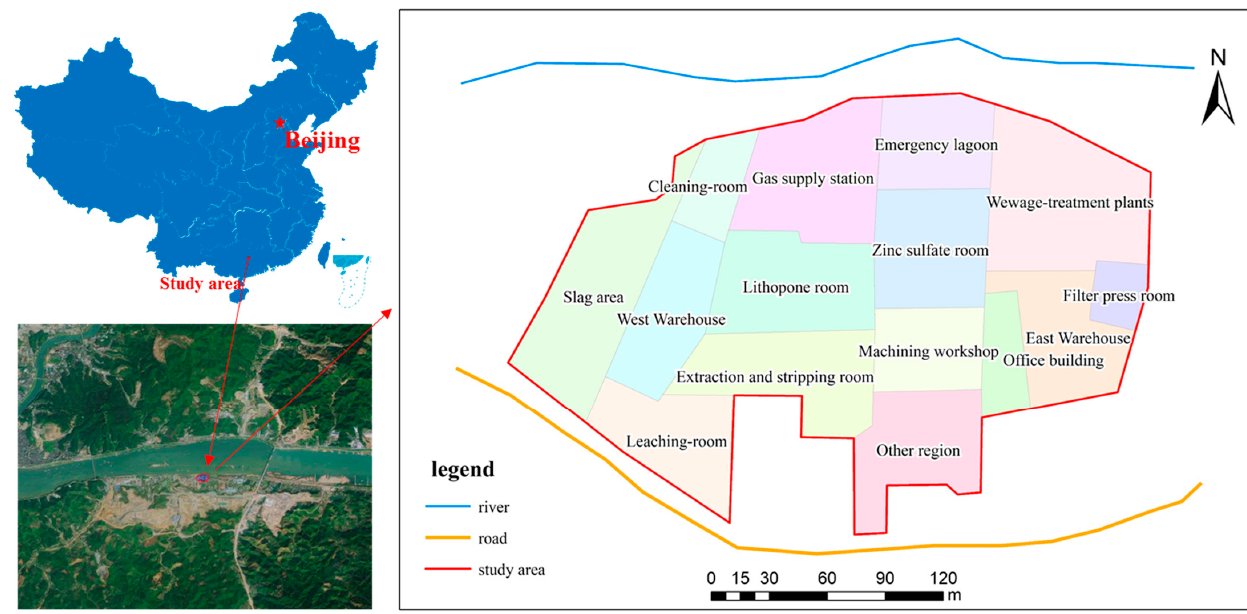
Figure 1. Location in the study